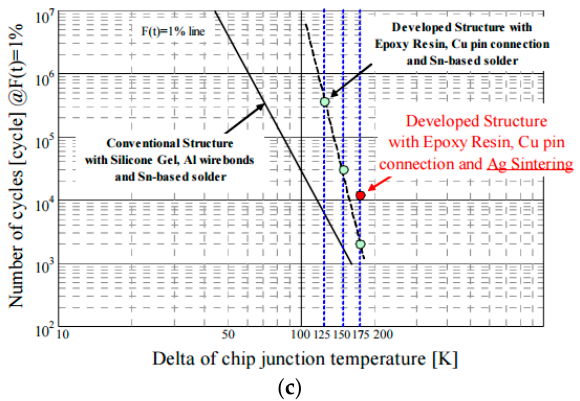
Figure 12. Copper pin interconnected epoxy molded design from Fuji Electric Co., Ltd. Showing: ( a ) a schematic of the cross-section of the package; ( b ) loss comparison between the developed structure and wire bonded SiC and Si variants; and ( c ) reliability curves against junction temperature and interconnect type [56]. Reprint with permission [4062741117252]; Copyright 2012, IEEE.